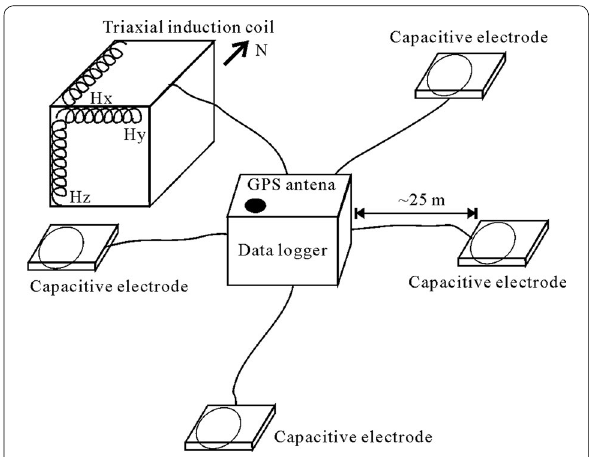
Fig. 2 Block diagram of the electromagnetic (EM) receiver (layout set as audio-frequency magnetotelluric (AMT) and controlled-source audio-frequency magnetotelluric (CSAMT) modules)